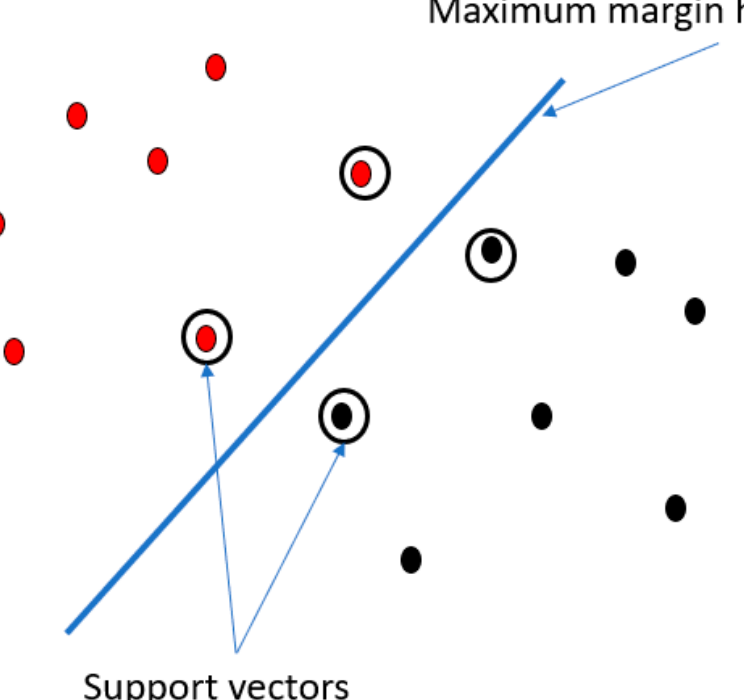
Figure 1. The figure shows the maximum margin hyperplane and support vectors. Points with different colours represent instances of different classes (the red and the black one).